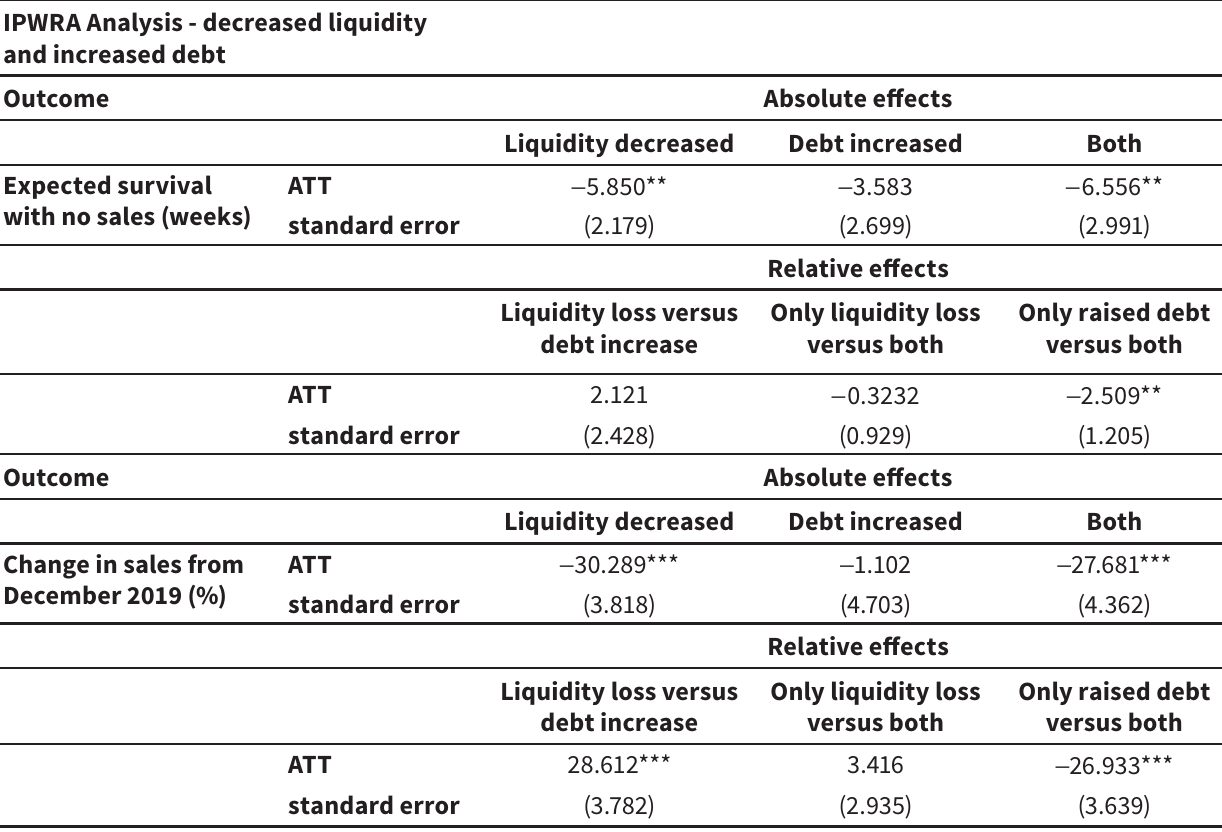
IPWRA analysis for online sales and remote